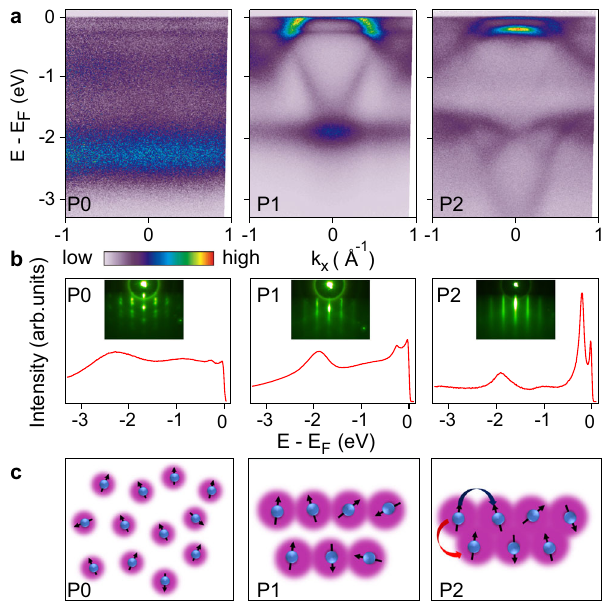
Fig. 1 Electronic structure of a thick Ce fi lm at 20 K after progressive post-growth annealings from ~370 to ~540 K. a Three representative ARPES spectra at different stages of annealings: disordered Ce fi lm (P0), ordered Ce fi lms at intermediate annealing temperature (P1), and at high annealing temperature (P2). b Energy distribution curves (EDCs) at the (cid:1) Γ point for these three phases. The insets are the corresponding RHEED images. c Cartoons illustrating the proposed origin of the different electronic structures. The reduction of the interlayer spacing in P2 is